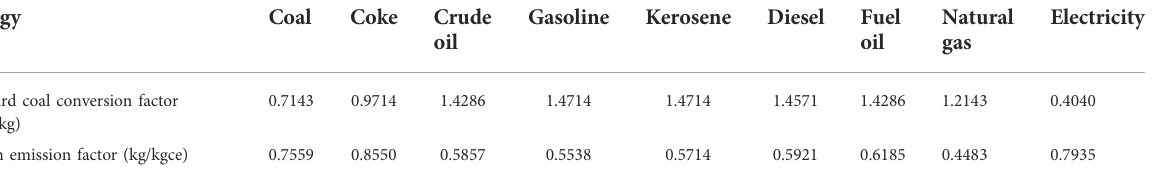
TABLE 2 Standard coal conversion factor of